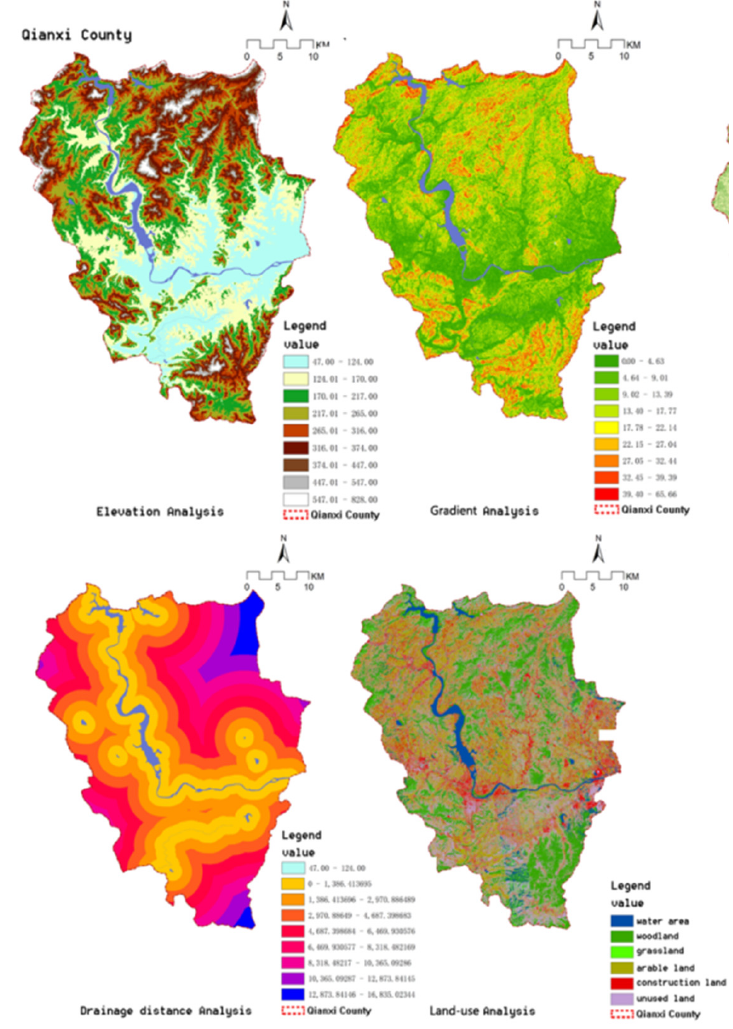
Figure 3. Single factor land ‐ use chart.